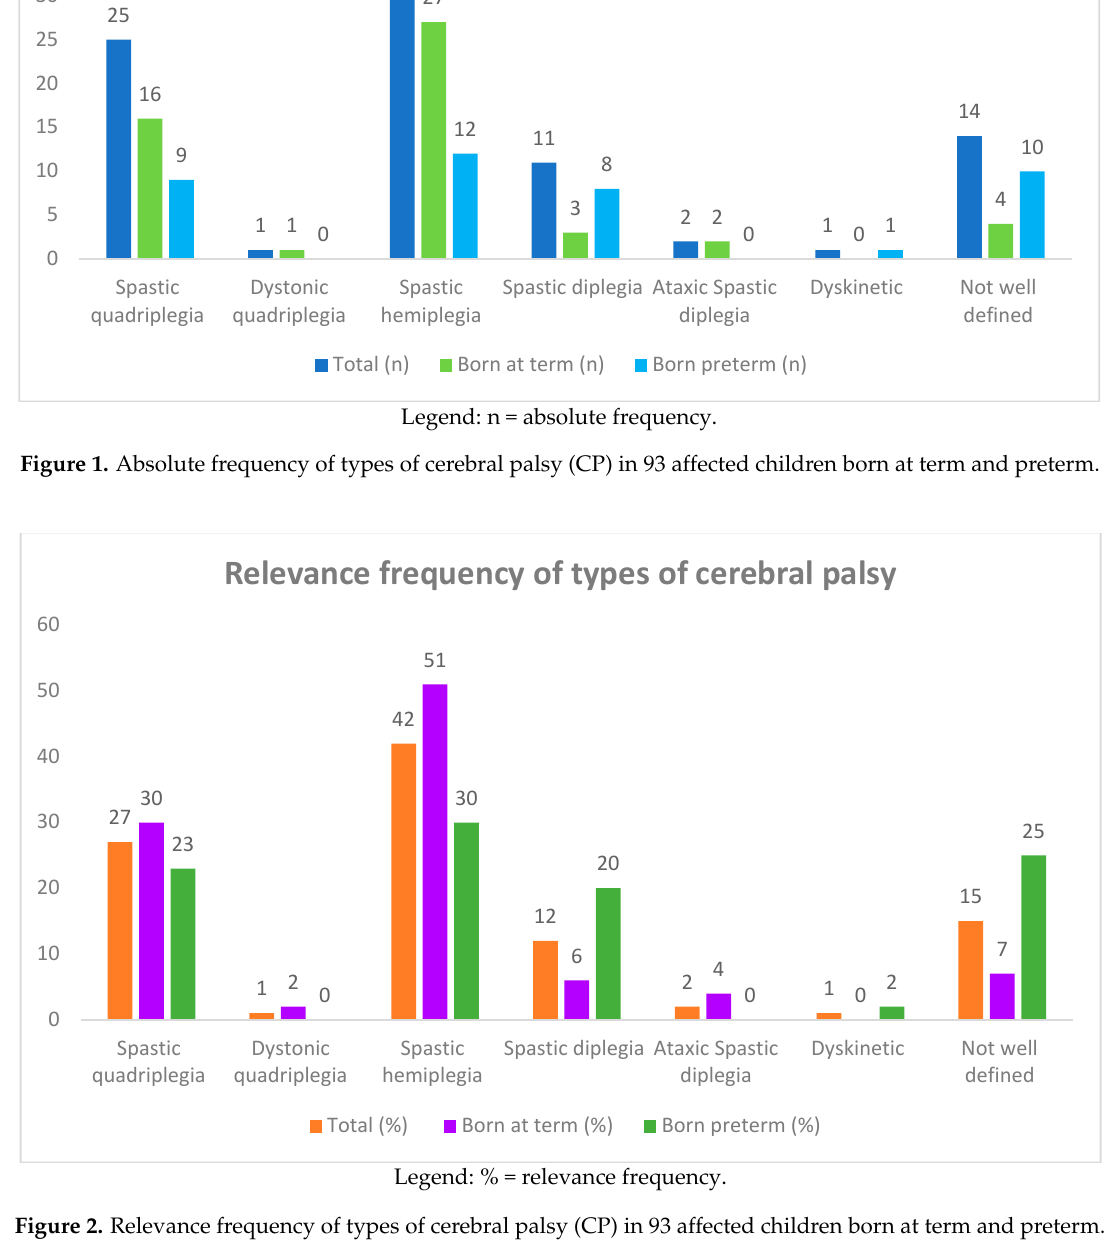
Figure 2. Relevance frequency of types of cerebral palsy (CP) in 93 affected children born at term and preterm.